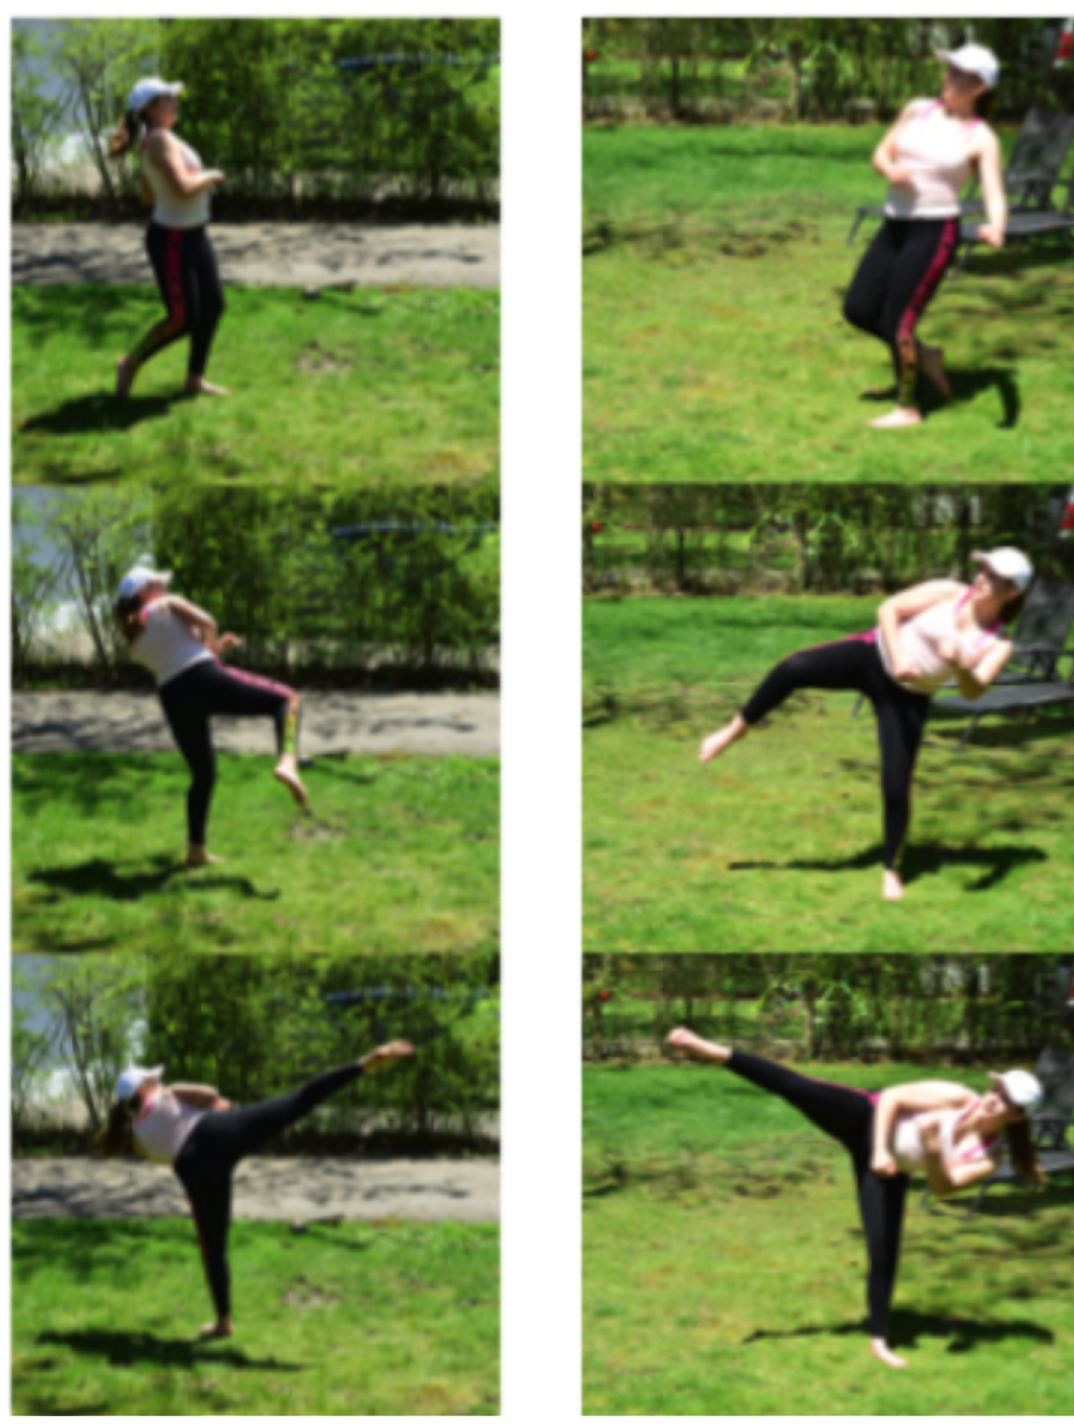
Fig 3. Roundhouse kick. Two views of a roundhouse kick, time proceeds downwards. Note the simultaneous rotation of the right front foot, which is used to generate rotation of the hips from frictional contact with the ground, as the rear foot is brought around. Also note the upper body is relatively still in comparison to the lower body. Bending motion of the waist alters the body’s rotation axis, bringing the foot up to the opponent’s head.